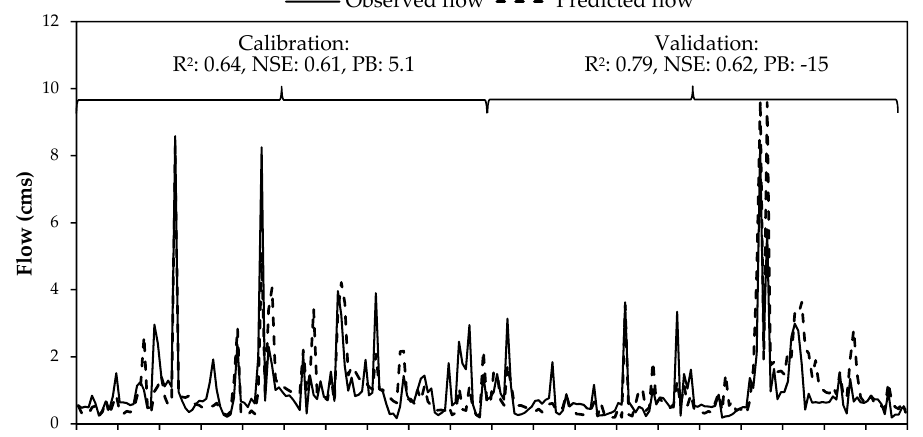
Figure 3. Average monthly observed and simulated streamflow for the calibration (1991–2000) and validation (2001–2010) periods.